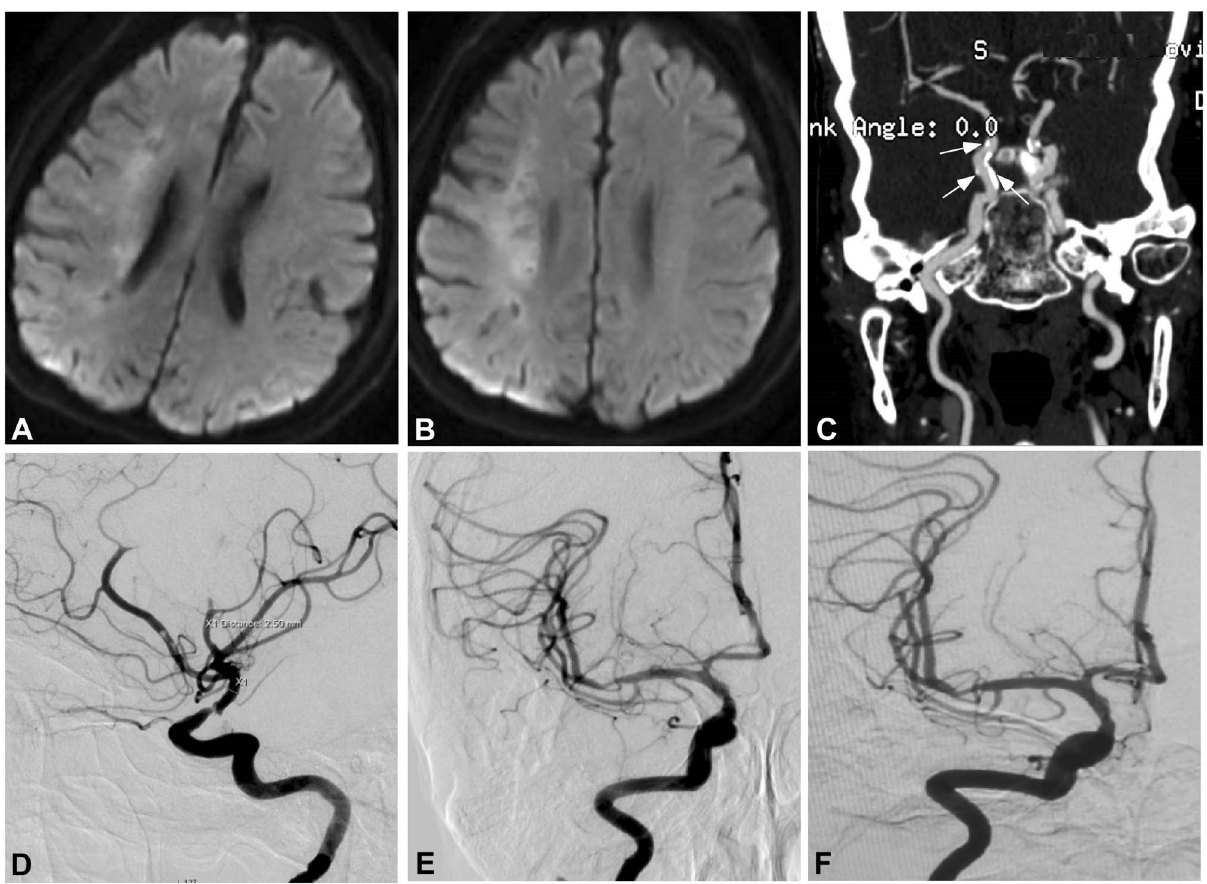
Figure 2. Right internal carotid artery severe stenosis. ( A ) Magnetic resonance imaging (MRI) showed an ischemic infarct at three days after onset. ( B ) MRI at 14 days after onset revealed increased area of the infarction. ( C ) Computed tomography revealed calcification (arrows) around the posterior communicating artery segment of the right internal carotid artery. ( D ) Cerebral digital subtraction angiography demonstrated severe stenosis at the posterior communicating artery segment of the right internal carotid artery. ( E ) Stent angioplasty was performed with an Enterprise stent and the severe stenosis disappeared. ( F ) Nine months after stent angioplasty, the stent remained